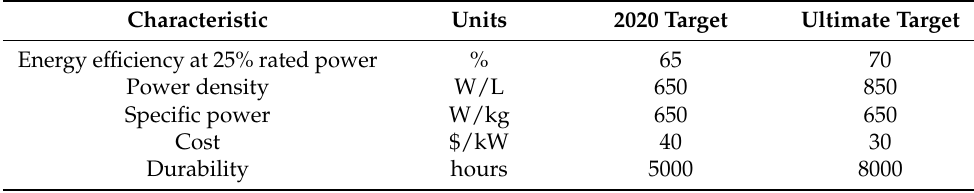
Table 6. DOE targets for automotive applications. Characteristic Units 2020 Target Ultimate